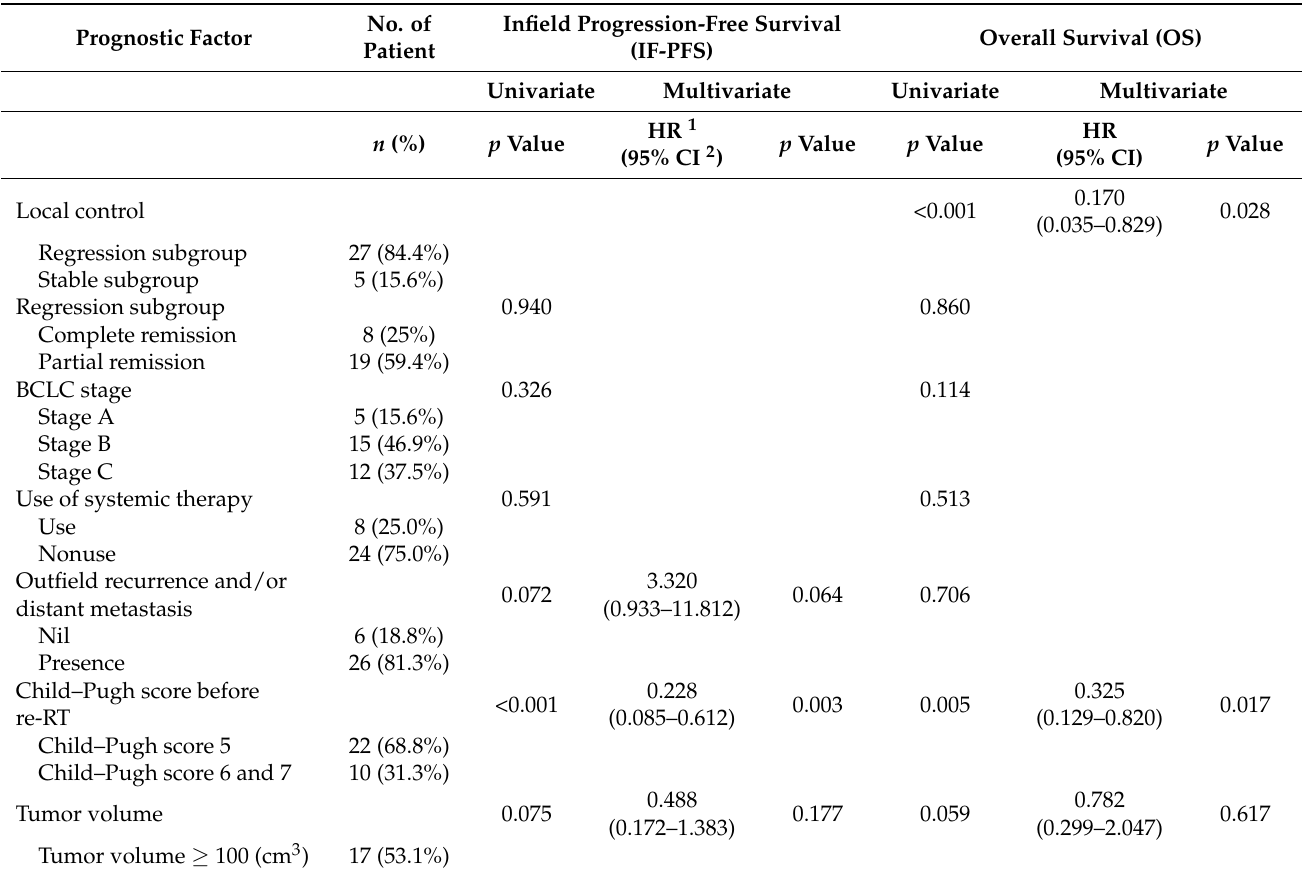
Table 2. Univariate and multivariate analysis of infield progression-free survival and overall